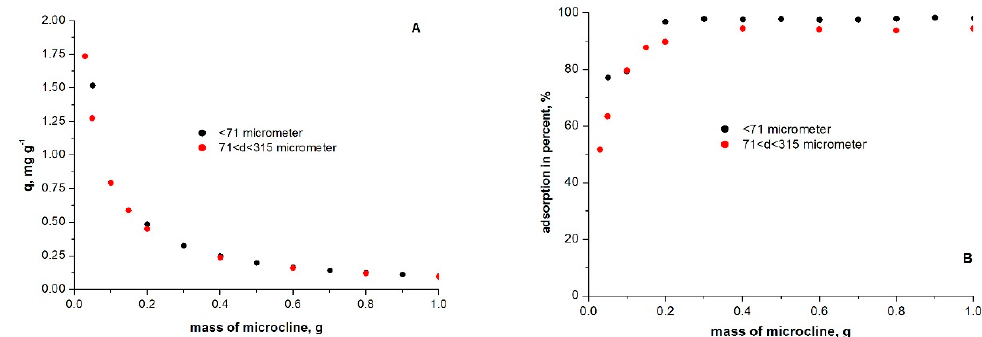
Figure 3. E ff ect of adsorbent dosage on methylene blue adsorption. ( A ) The dye adsorption capacity on microcline particles and ( B ) dye adsorption in percent are presented in the function of microcline mass-containing particles smaller than 71 µ m ( d < 71 µ m) and particles in the range from 71 µ m up to 315 µ m (71 µ m < d < 315 µ m) in aqueous suspensions. (10 mg L − 1 dye concentration, at room temperature, in 10 mL of